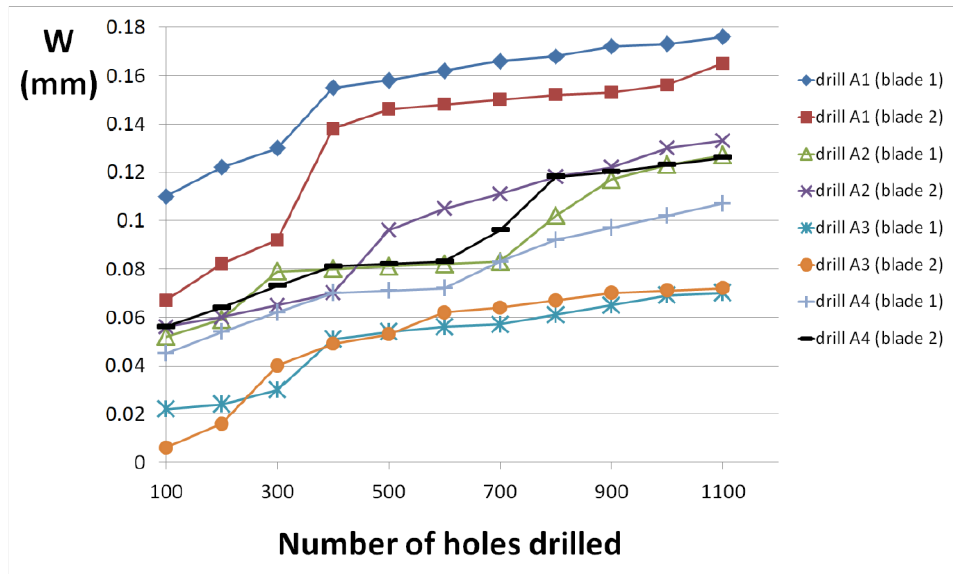
Figure 9. The blade wear curves for drill bits from Group A (control group containing four two-blade tools that were unmodified). R 2 stands for the coefficient of determination.